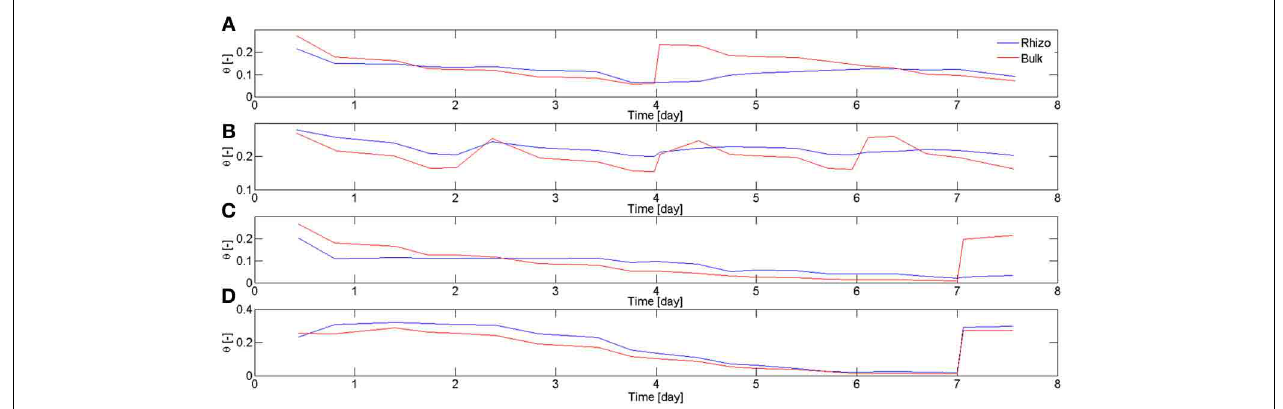
FIGURE 5 | Water content in bulk soil θ b and rhizosphere θ rh during drying and rewetting calculated for different samples and at different soil depth. Time is calculated from the start of 1st drying cycle when the plants were 2 weeks old. (A) Average θ b and θ rh calculated in the top 5cm of L4. During the drying period (day 2–4), the rhizosphere was wetter than the bulk soil. The situation reversed after irrigation, with the rhizosphere remaining temporarily dry. The rhizosphere slowly rewetted during the next 2 days. (B) θ b and θ rh at the top 5cm of L1. The